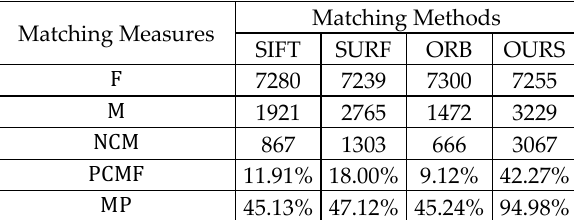
Table 3. Matching measures for the second image pair when using SIFT, SURF, ORB and our proposed method.